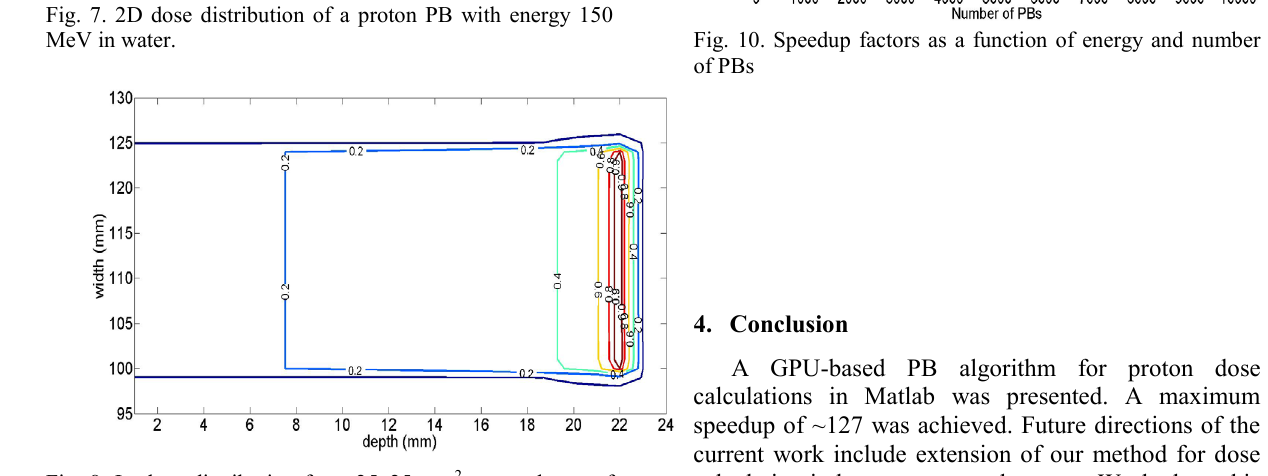
Fig. 8. Isodose distribution for a 25x25 mm 2 proton beam of 50 MeV in water.